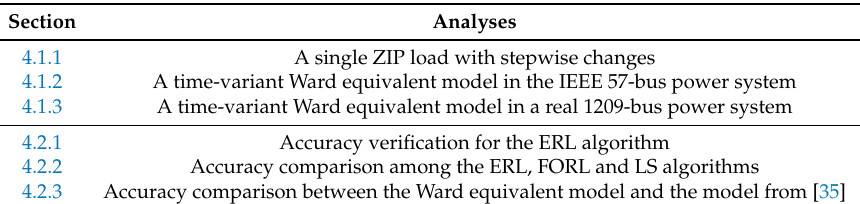
Table 2. Summary of the